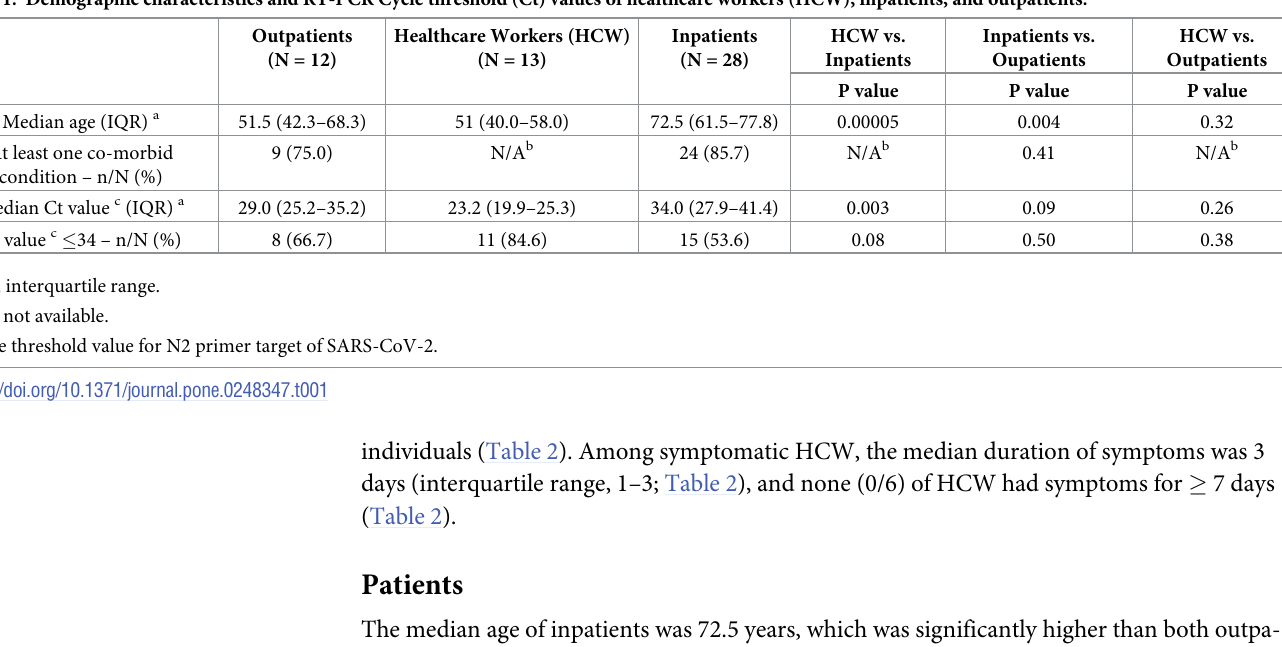
(Table 2). Patients